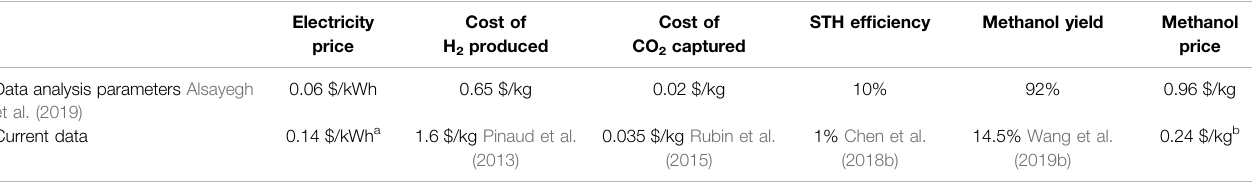
TABLE 2 | Optimization parameters of techno-economic analysis and current